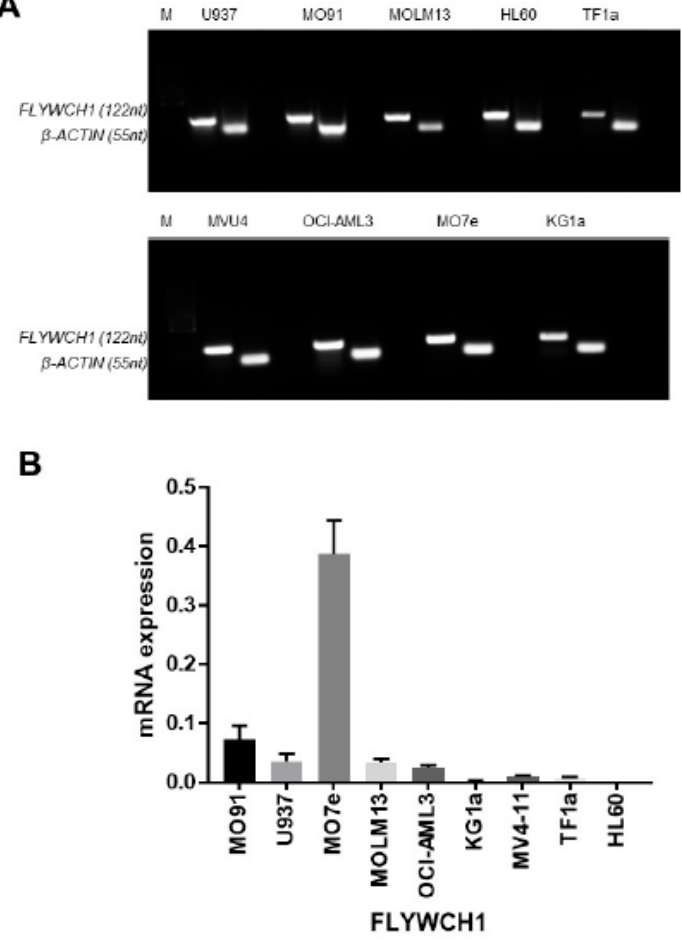
Figure 1. FLYWCH1 mRNA is differentially expressed in acute myeloid leukaemia (AML) cells. ( A ) RT-PCR of FLYWCH1 (129 bp) in AML cell lines; β -actin (55 bp) was the housekeeping gene. The samples were electrophoresed in an ethidium bromide–stained agarose gel. ( B ) qRT-PCR analysis of FLYWCH1 mRNA expression in AML cell lines. Data were normalized to β -actin according to its threshold cycle values, where the comparative threshold cycle value (2 − ∆ Ct ) was calculated. Error bars show the SD of triplicates samples, from 3 independent measurements.